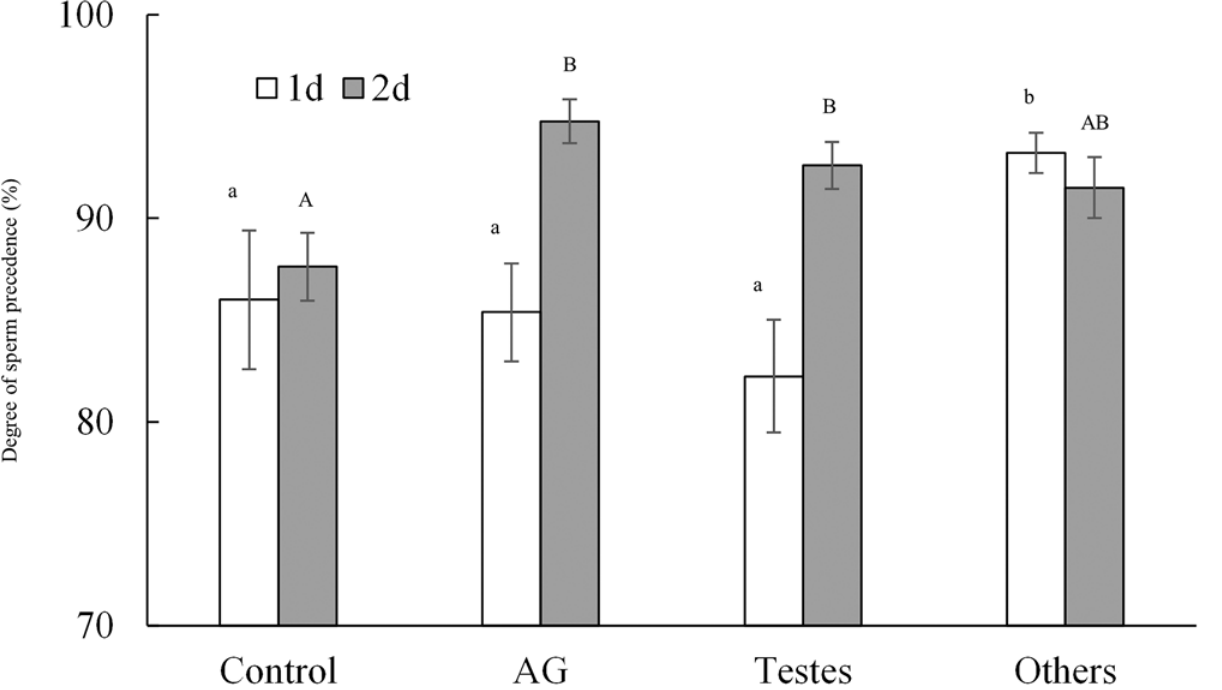
Fig 1. Competitive fertilization success of the second male to mate with females injected with extracts of male reproductive tracts. The figure shows the mean ( ± SE) degree of second male sperm precedence when females remated to a fertile focal male 1 or 2 days after first mating with a sterilized male. Females (N = 29 – 42 per day and treatment group) were injected with an aqueous solution of an extract of accessory glands (AG), testes, seminal vesicle and ejaculatory duct (others) or with Milli-Q water only as a control. Identical letters indicate no significant difference by sequential Bonferroni post-hoc tests [48] at α = 0.05.